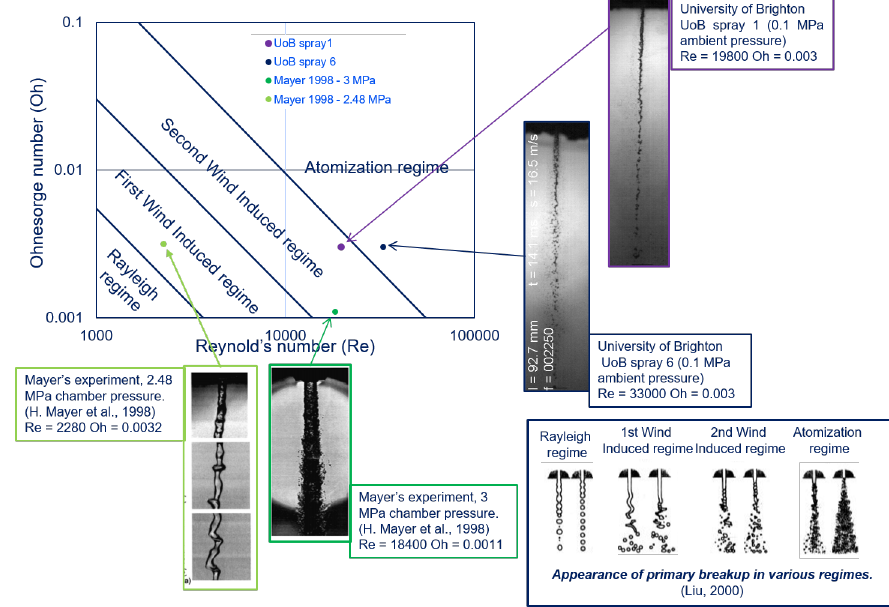
Figure 7. Primary atomisation regime classification of subcritical cryogenic jets from Mayer’s experiments [7] and in-house University of Brighton experiments. The appearance of primary fluid jet breakup at various breakup regimes by Liu [25] is also depicted at the